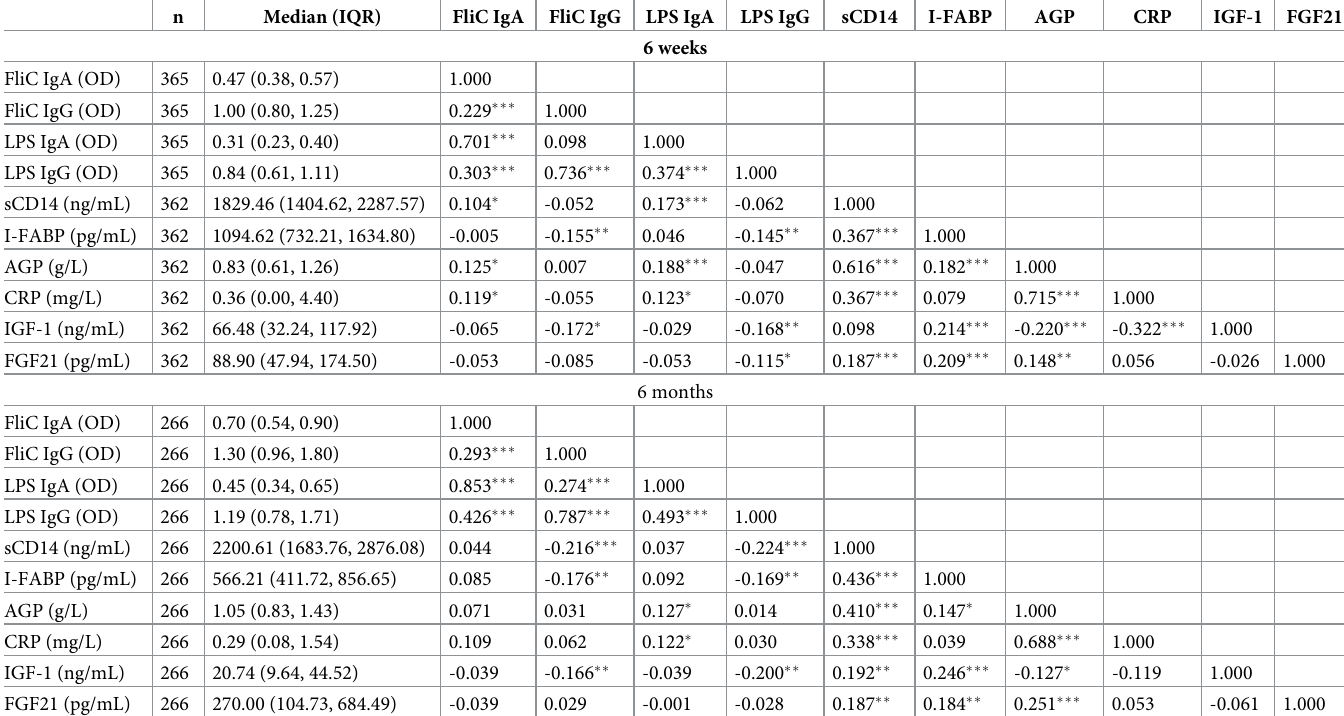
Table 2. Correlation coefficient matrix of biomarker concentrations at 6 weeks and 6 months of age 1